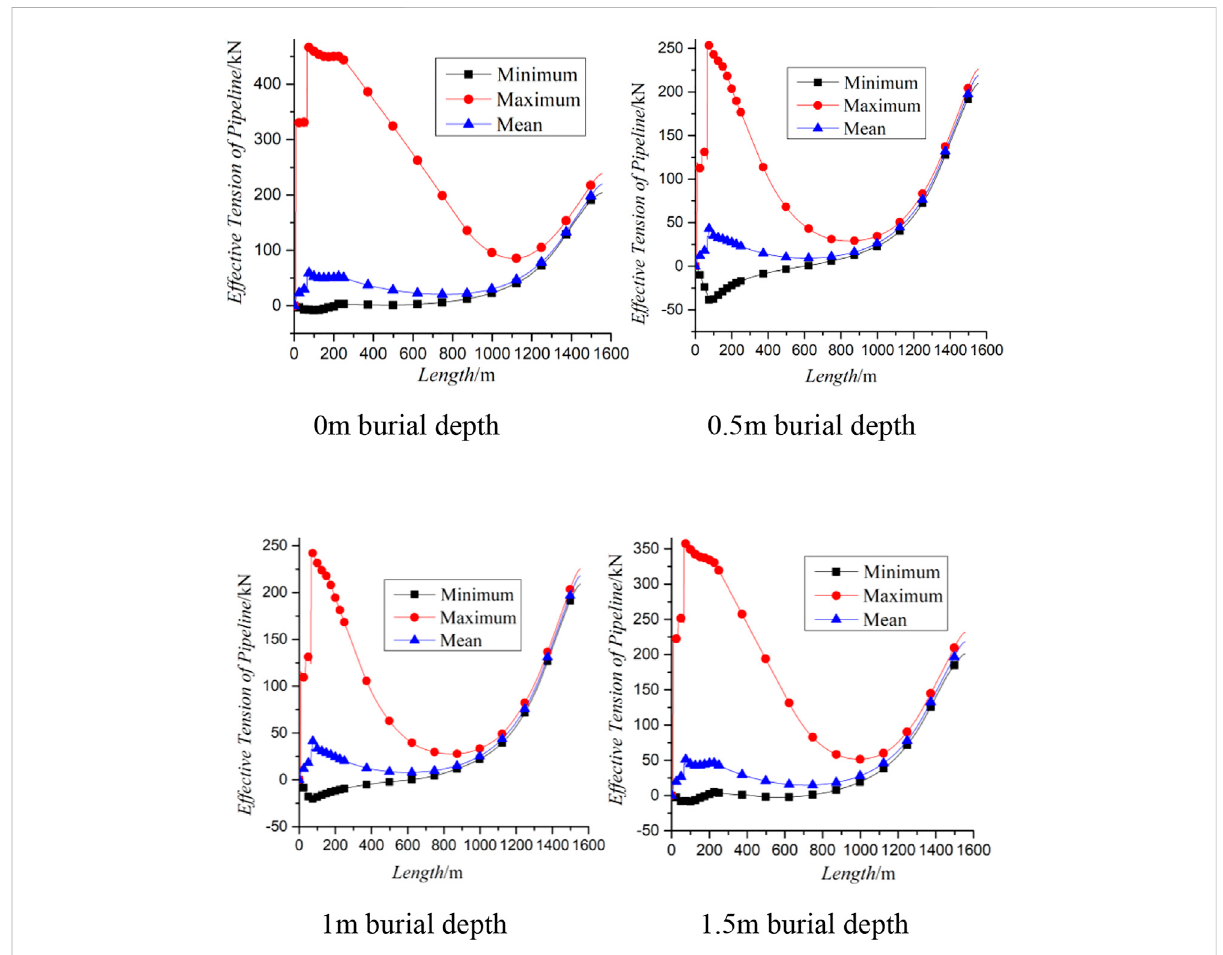
FIGURE 6 Effective tension of the pipeline in the length direction with different burial